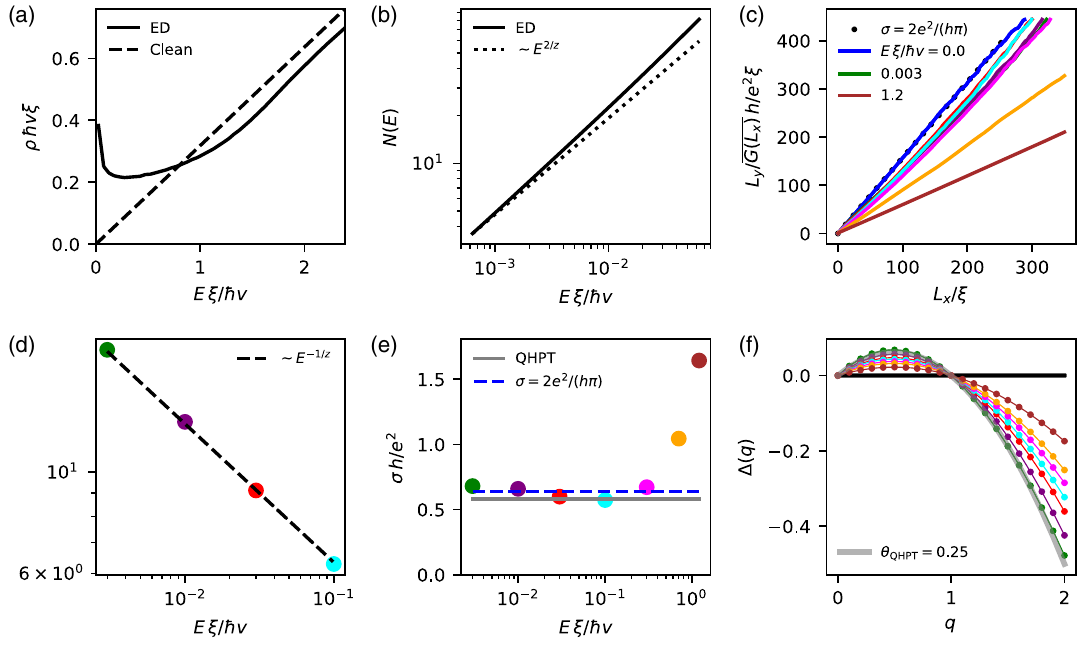
FIG. 4. Numerical results for the topological class AIII surface model with two Dirac nodes ( ν ¼ 2 ), defined by Eq. (6) and protected by the “ anomalous ” chiral symmetry in Eq. (5). The Abelian and non-Abelian vector potential disorder strengths are W 1 . 5 , respectively [cf. Eq. (16)]. (a) The DOS as a function of energy, as calculated from ED (200 disorder realizations). (b) The W R N ¼ ερ ð ε Þ plotted versus energy. The predicted scaling form implied by Eq. (12) is governed by the dynamical E integrated DOS N ð E Þ ¼ 0 d = π , which depends only on the Abelian disorder strength. (c) Quantum transport results for the critical exponent z ¼ 7 = 4 þ W 2 A 400 ξ , averaged over 600 disorder realizations. The energies are from top to bottom resistance normalized to system width L y ¼ E ξ = ℏ v ¼ 0 , 0.003, 0.01, 0.03, 0.1, 0.3, 0.7, 1.2. (d) The crossover length from the transport calculation scales as the correlation length ζ ∼ E − 1 =z . (e) Conductivities extracted from the L ≥ 200 ξ slopes of the curves in (c), compared to the established value of the QHPT x critical conductivity. (f) Anomalous part of the multifractal spectrum Δ ð q Þ extracted from box-size scaling of ED eigenstates for box sizes beyond the correlation length ζ as extracted in (d). The data correspond to E ξ = ℏ v ¼ 0 . 003 , 0.01, 0.03, 0.1, 0.3, 0.7, 1.2 (bottom to top at q ¼ 2